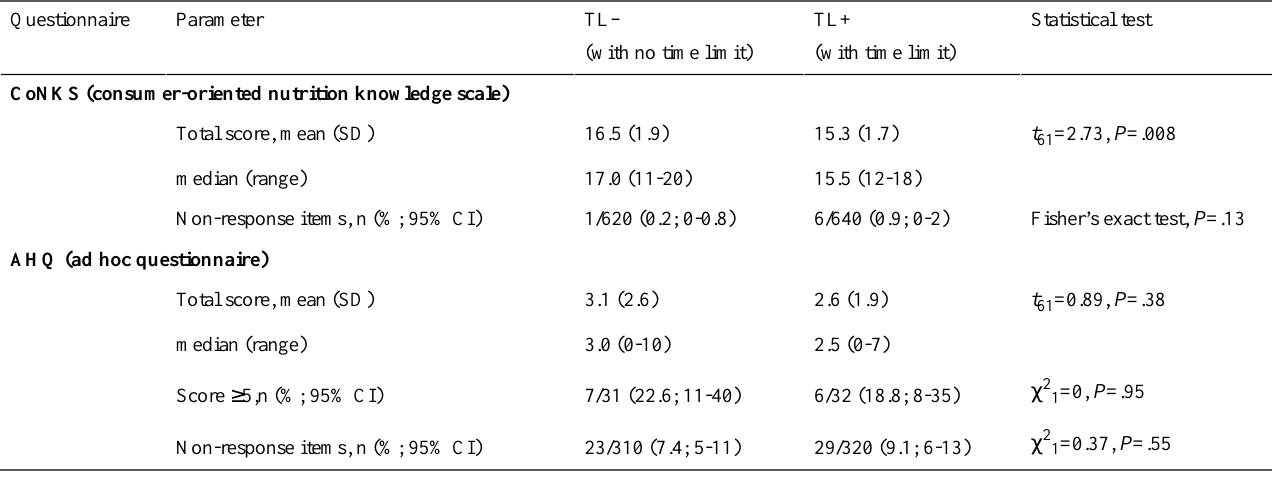
Table 2. Participants’performances on the survey instruments.